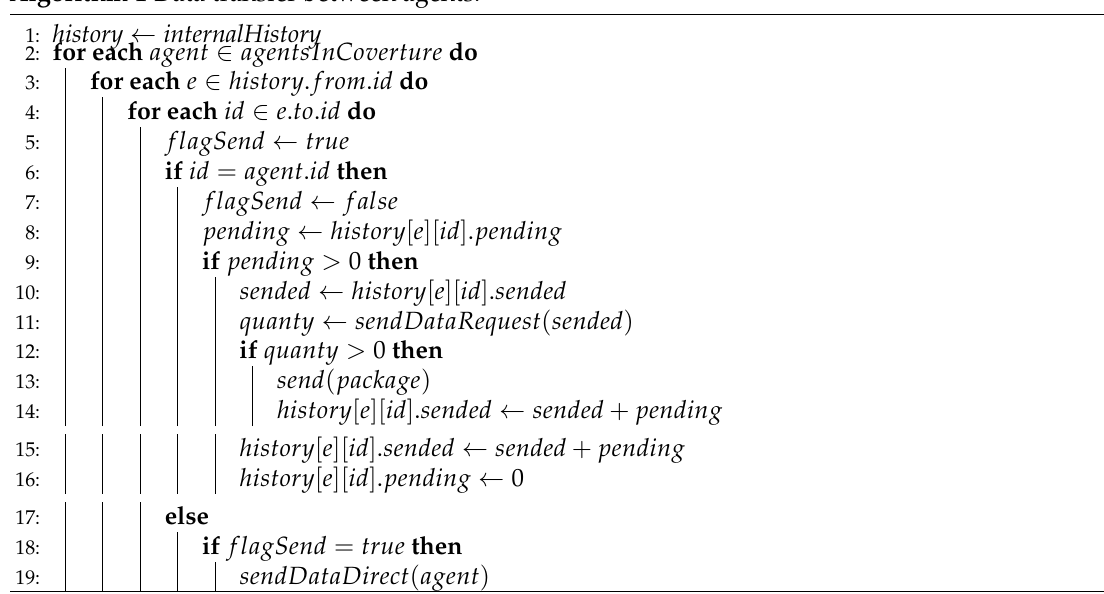
Algorithm 1 Data transfer between